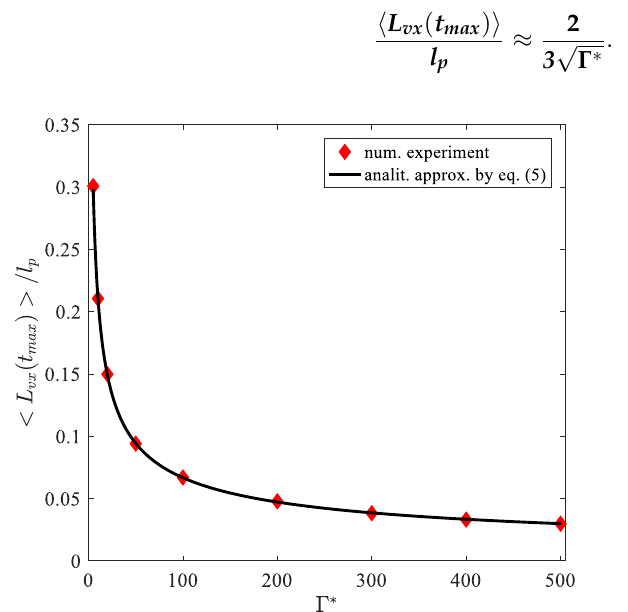
Figure 6. Dependence of the maximum values of the average linear displacements of active particles in a plasma-dust monolayer along the vectors of the initial velocities on the steady-state effective parameter of nonideality of the system.